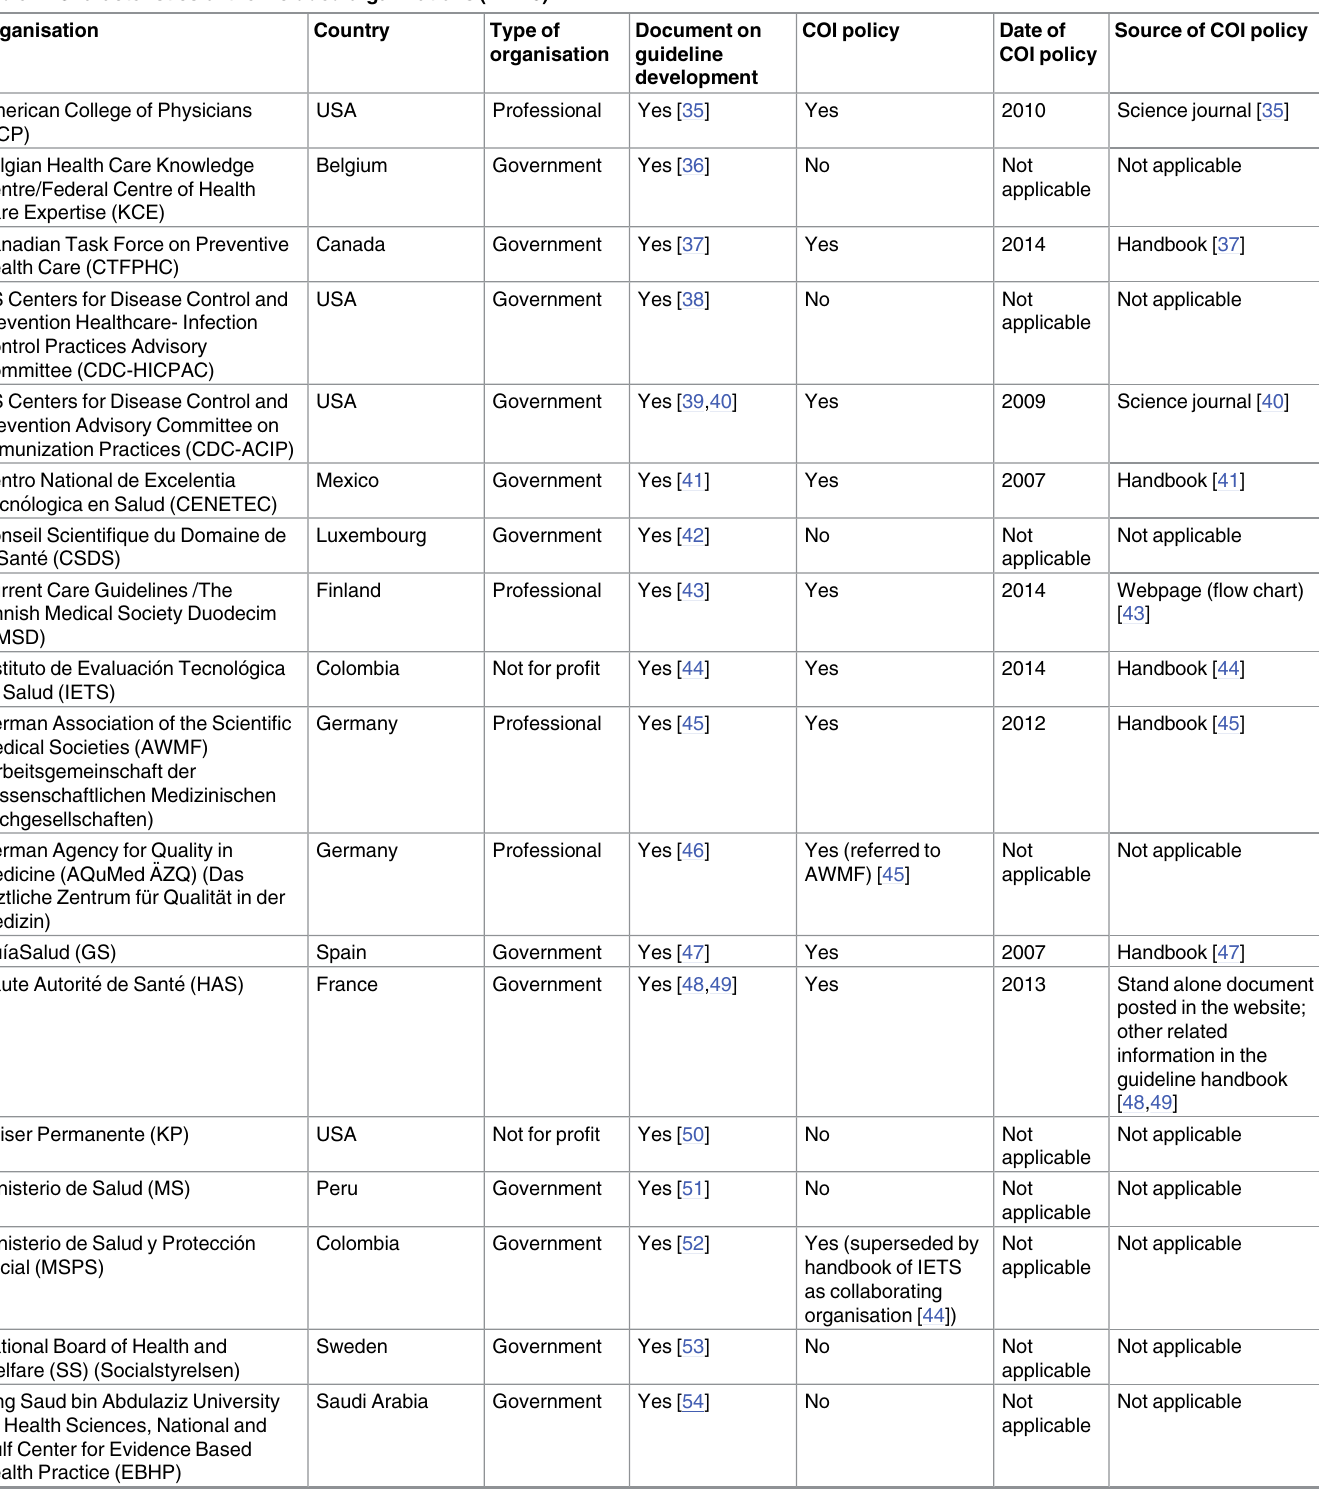
Table 2. Characteristics of the included organizations (N =